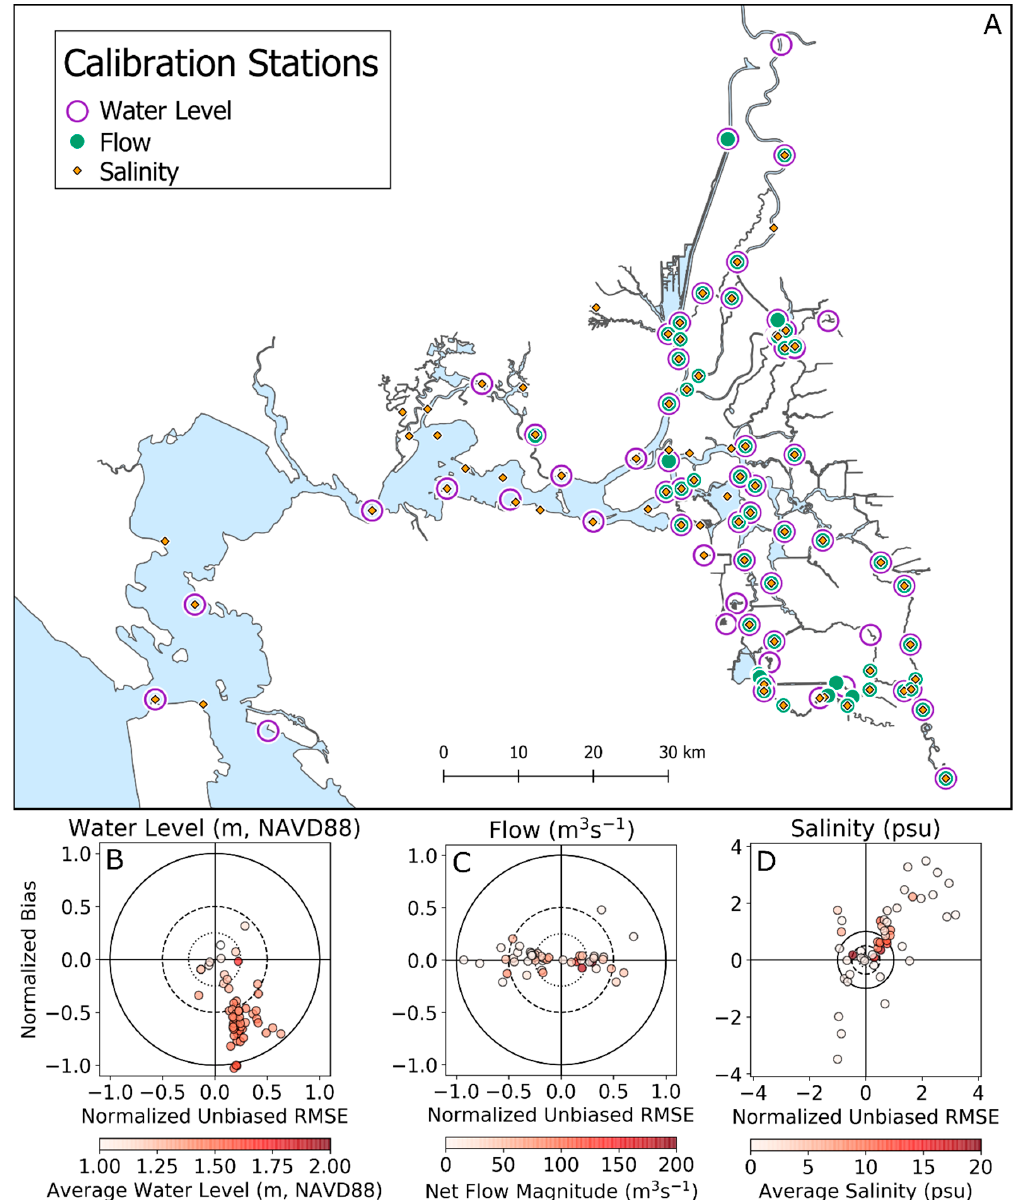
Figure 3. ( A ) Model calibration stations and ( B – D ) model calibration target diagrams for ( A ) water level, ( B ) flow, and ( C ) salinity in 2014. The normalized bias metric for eight of the 57 salinity stations lies outside of the axis bounds.